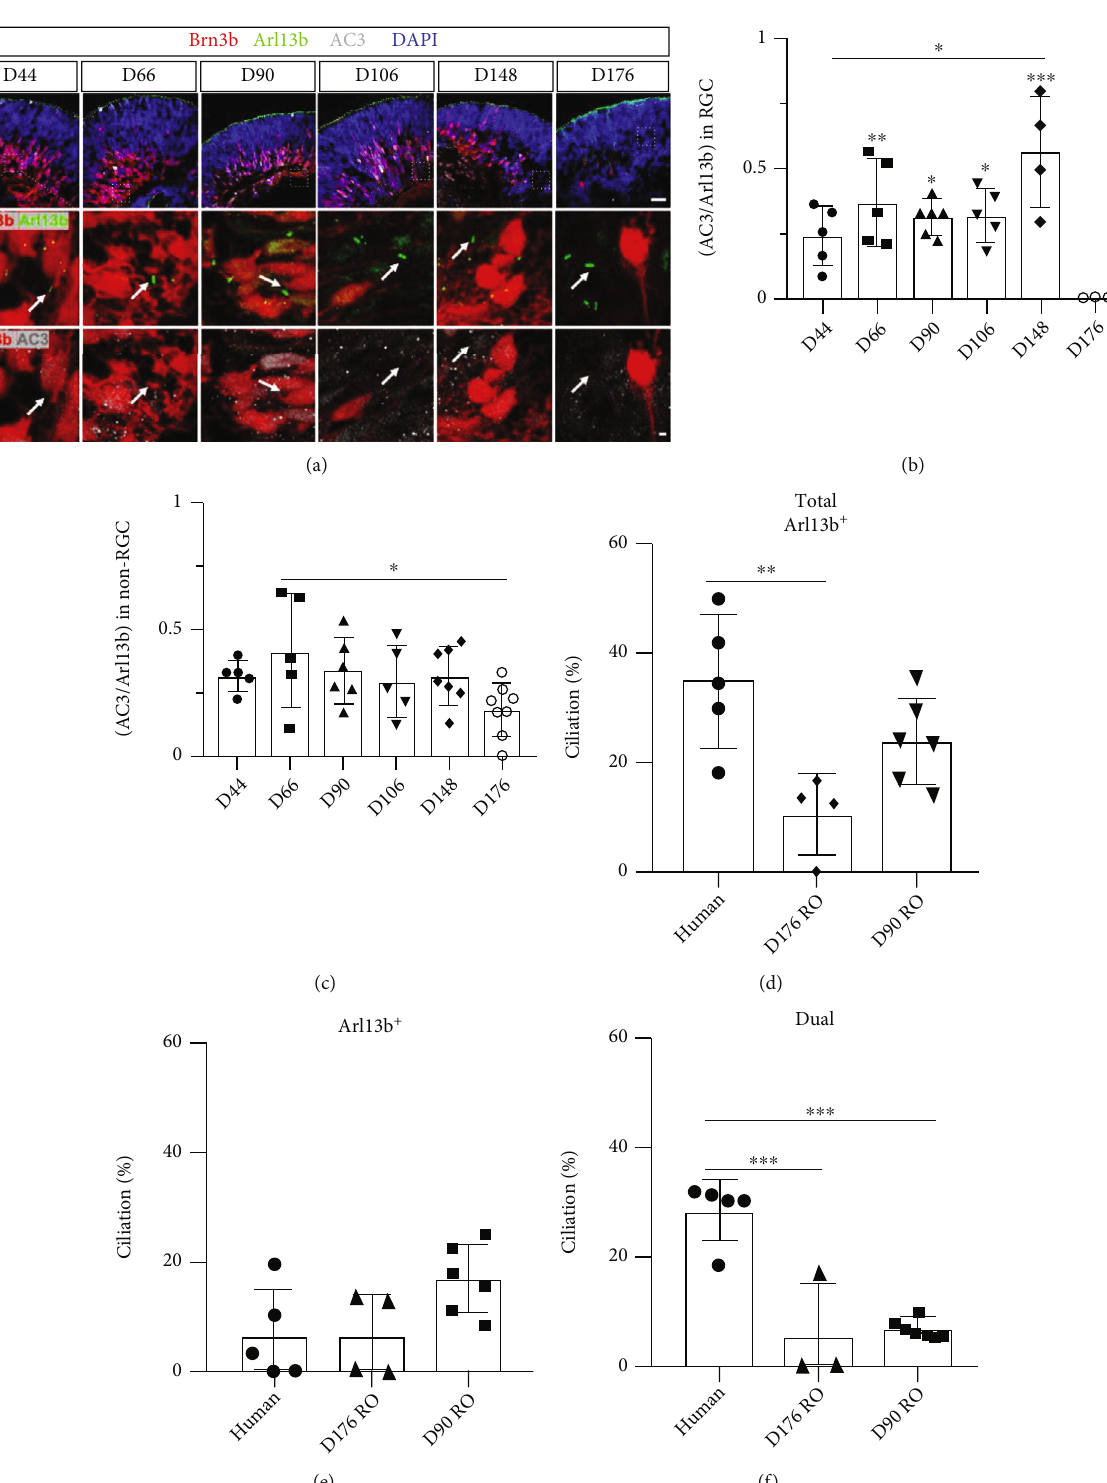
Figure 5: Decreased number of AC3-positive ciliated RGCs in retinal organoids. (a) Representative images illustrating retinal organoids immunostained with neuronal cilia marker AC3 (gray), and prototypical cilia marker Arl13b (green). RGCs are visualized by Brn3b- tdTomato (red), and nuclei are stained with DAPI (blue). Primary cilia labeled with AC3 and/or Arl13b can be localized to Brn3b- positive RGCs (white arrows). (b, c) Quanti fi cation of the ratio of AC3-positive cilia with respect to the total number of Arl13b-positive cilia in Brn3b-positive RGCs (b) and non-RGCs (c). (d-f) Quanti fi cation of precent ciliated RGCs in human retina, day 176 and day 90 of retinal organoids. Values represent mean ±